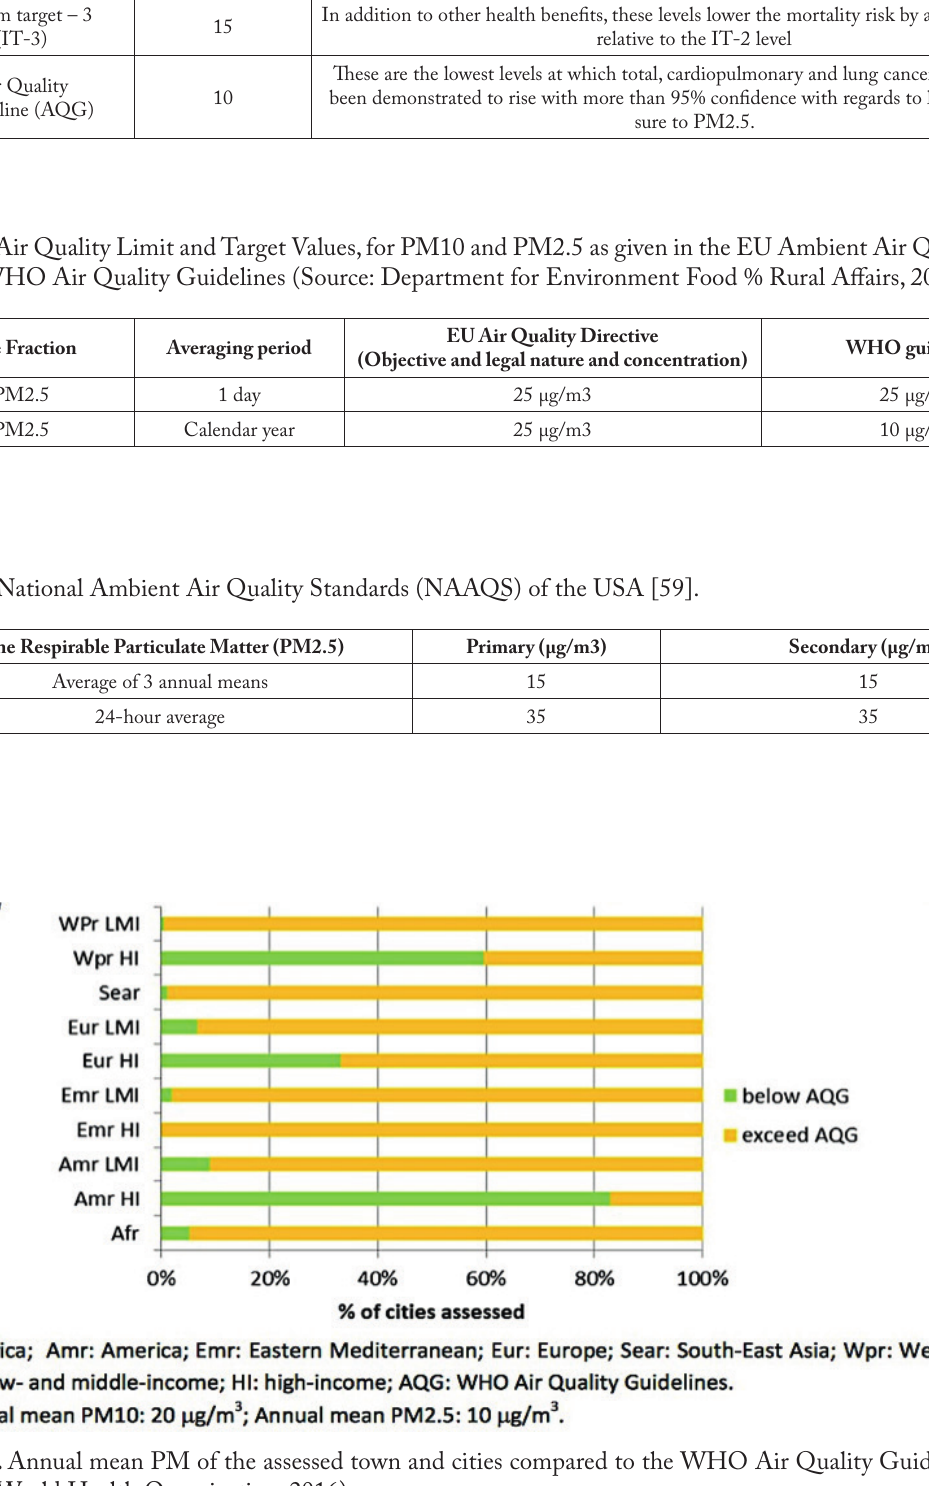
Figure 4. Annual mean PM of the assessed town and cities compared to the WHO Air Quality Guidelines (AQG). (Source: World Health Organization,